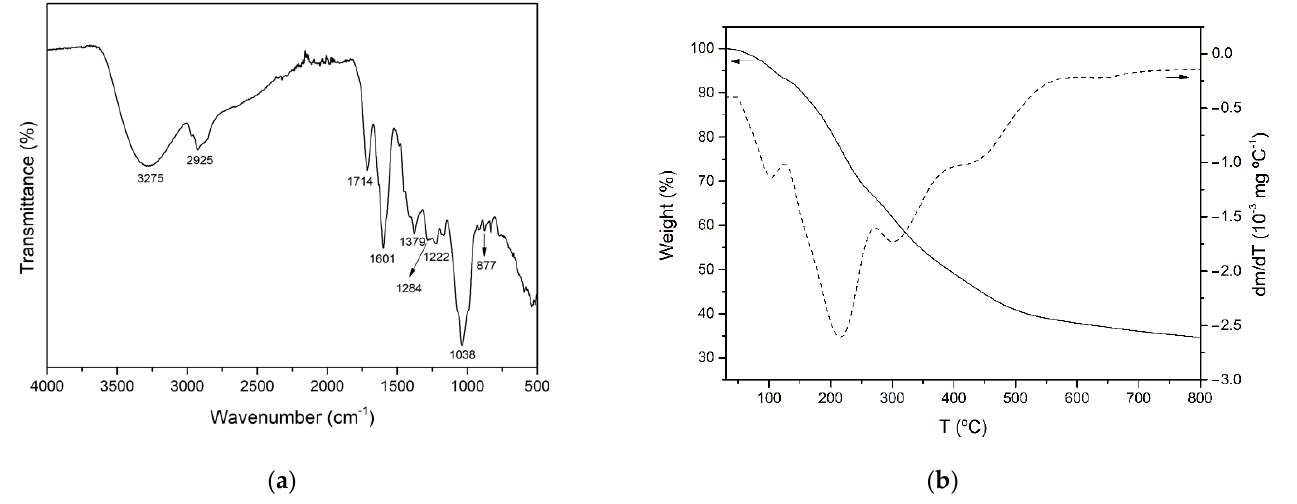
Figure 2. FTIR spectrum ( a ) and TGA and DTGA thermograms ( b ) of AVE obtained under optimal MAE conditions.